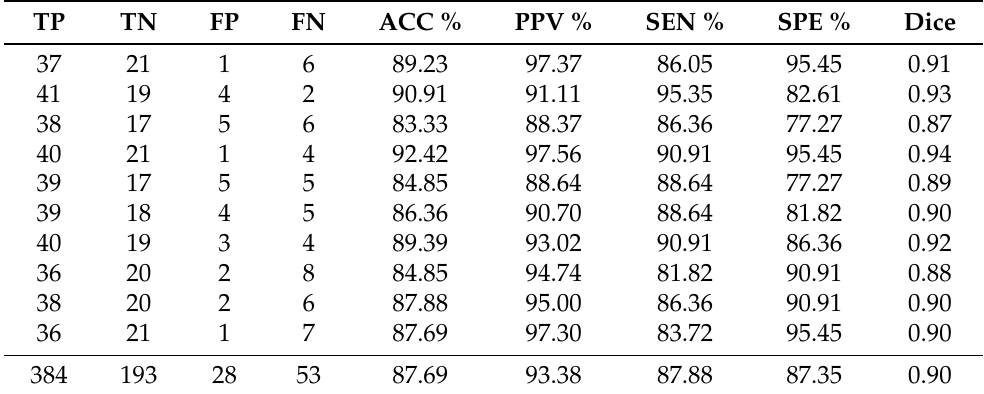
Table 1. SVM with linear kernel. The first 10 rows in the table document the performance results for each individual fold. The last row states the averaged performance results.